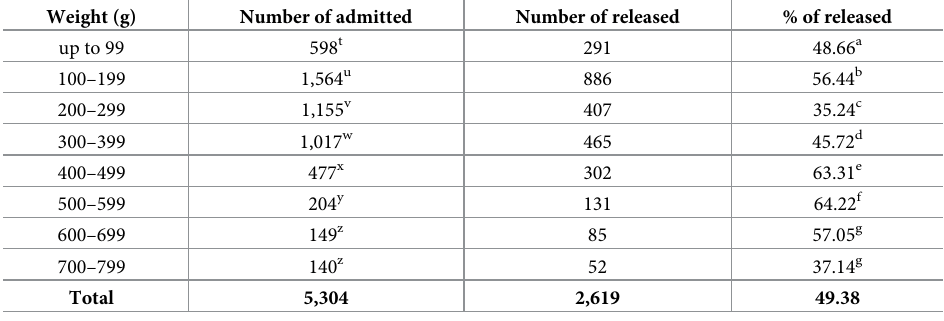
Total 49.38 a-g The values with different superscript letters in a column (% of released) are significantly (p < 0.05) different (Fisher´s exact test). t-z The values with different superscript letters in a column (number of admitted hedgehogs) are significantly (p < 0.05) different (Fisher´s exact test).